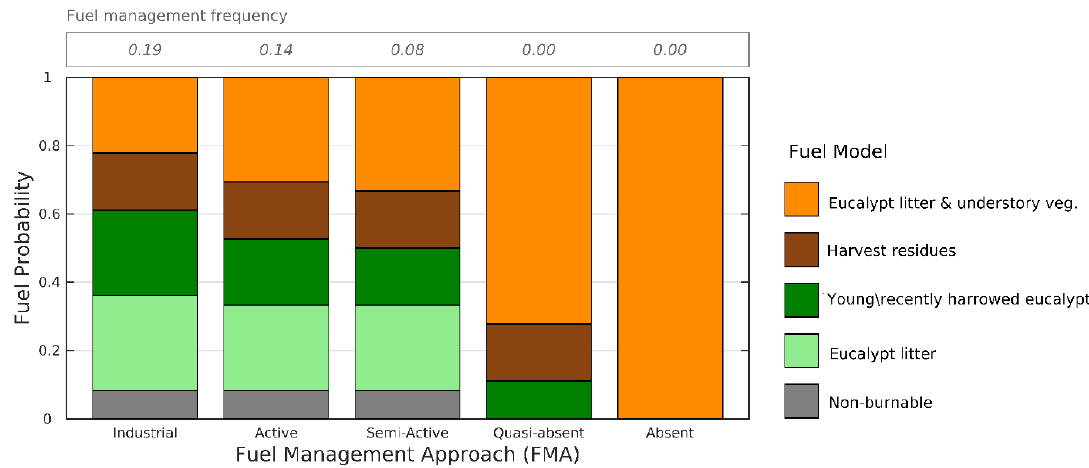
Figure 3. Fuel model probability for each forest management approach. Fuel management frequency was calculated as the fraction of harrowing operations in 40 years.